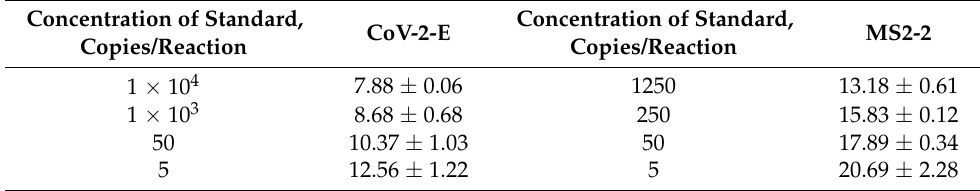
Table 2. Time-to-threshold (Tt) values for LAMP with RNA template and primer sets CoV-2-E and MS2-2.